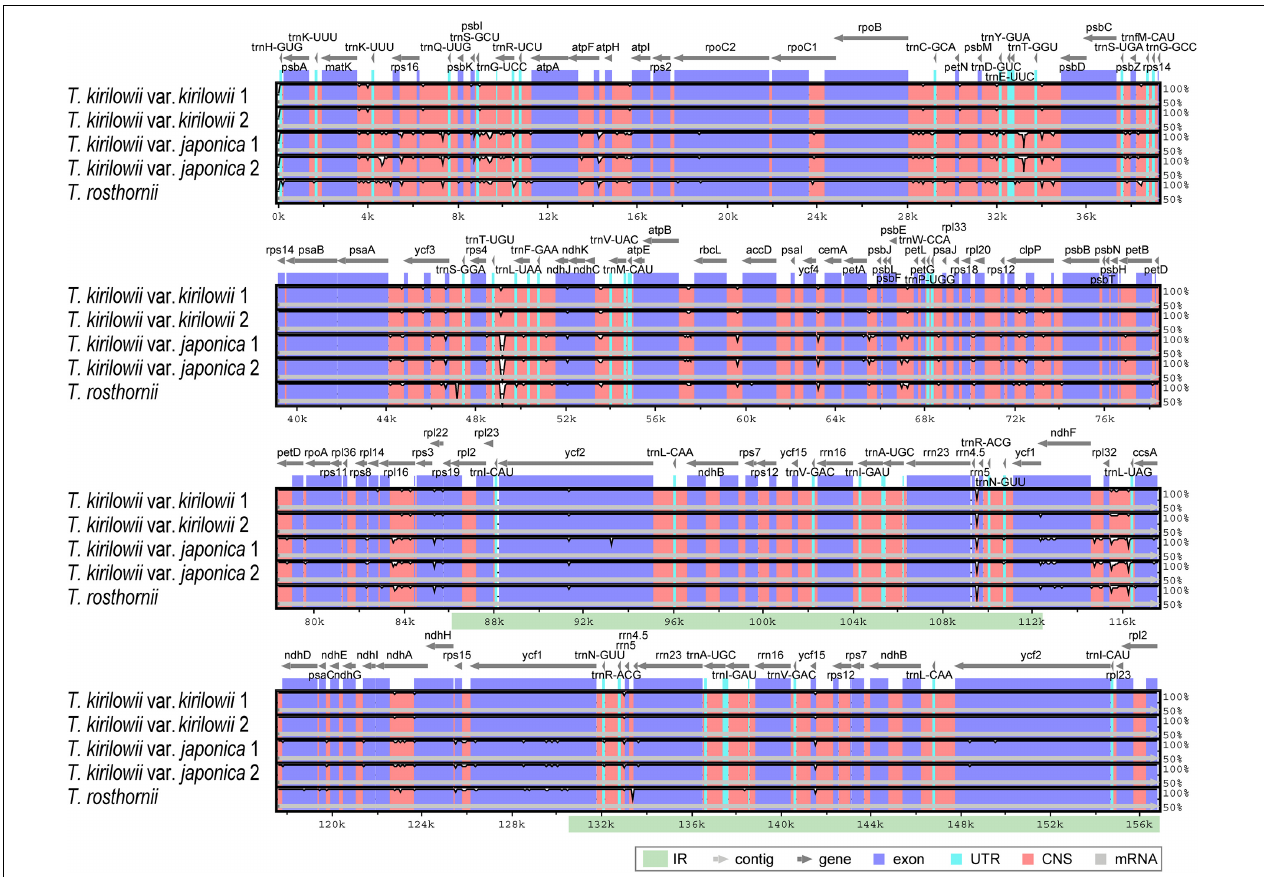
FIGURE 4 | Comparison of Trichosanthes plastid genomes using mVISTA. Complete plastid genomes of five Trichosanthes species were compared, with T. kirilowii var. kirilowii 1 as the reference. The gray arrows above the alignment indicate genes. Different colors represent different regions (coding and non-coding). The horizontal axis indicates the coordinates within the chloroplast genome. The vertical scale represents the percentage of identity, ranging from 50 to